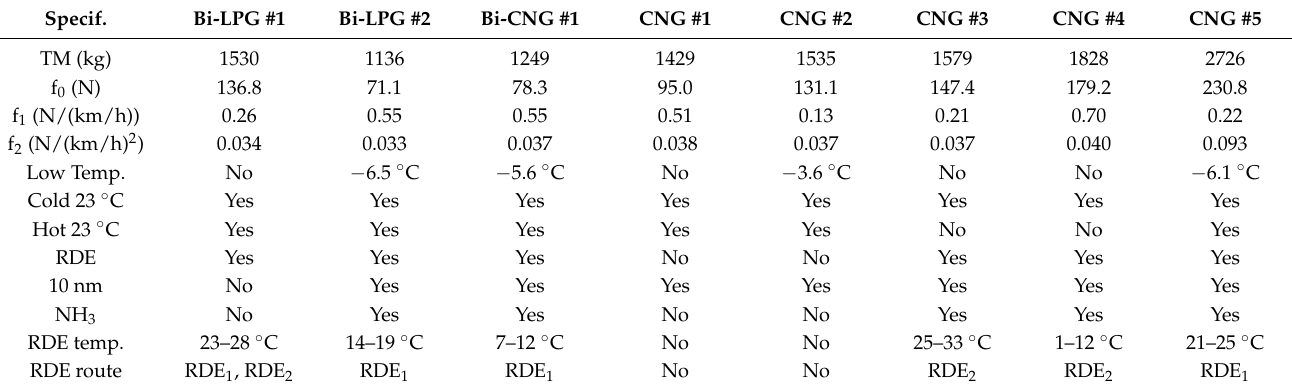
Table 6. Test protocol and parameters. TM is the test mass and f 0 -f 2 are road-load coefficients that were used at the laboratory. The actual temperature at the beginning of the “Low Temp.” tests are given. RDE 1 and RDE 2 refer to two different routes, but both RDE regulation compliant.